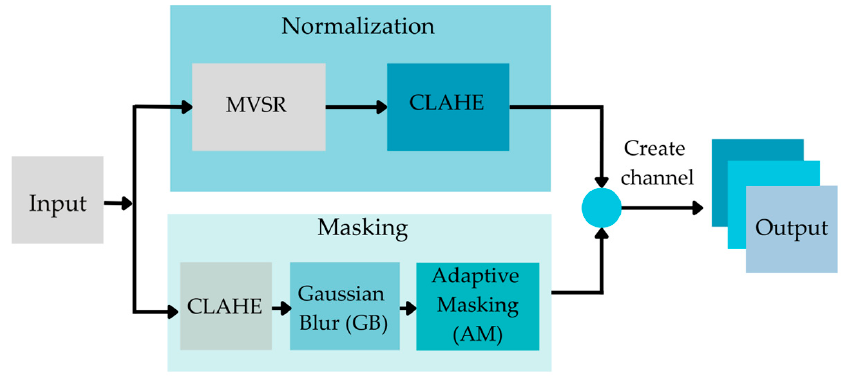
Figure 4. Framework of the data normalizing model.